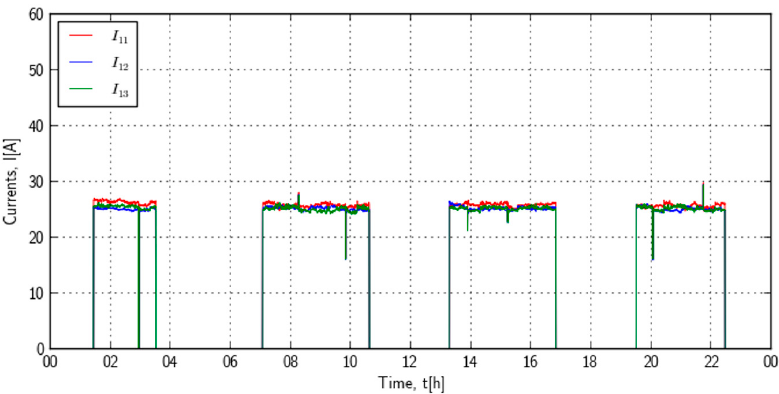
Figure 16. The diagrams of the load current changes in PU1 recorded on 27 June 2009.